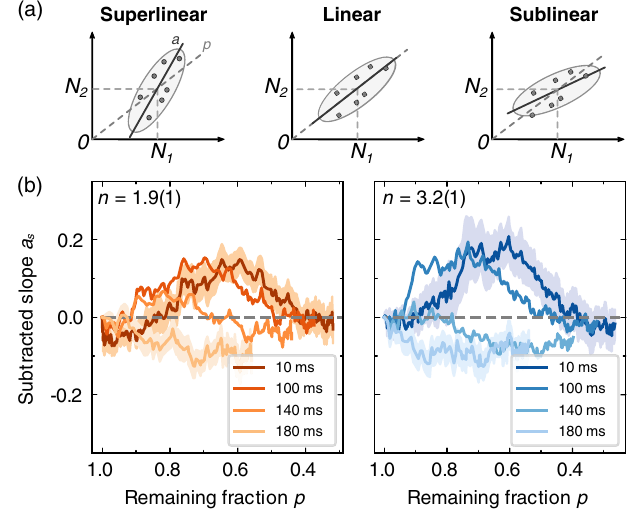
FIG. 3. Nonlinearity of the evaporation process. (a) Schematic illustrating the nonlinearity measure. Superlinearity (sublinearity) is equivalent to a slope a of the scatter of N 2 versus N 1 that is larger (smaller) than the remaining fraction of atoms p . For a ¼ a − p for linear process, a ¼ p . (b) Subtracted slope a s different initial times t 1 (dark to bright color, indicated in the legend) used to quantify the nonlinearity of the evaporation process versus remaining fraction of atoms p . The shaded region shows the standard deviation calculated by bootstrapping for the smallest and largest initial